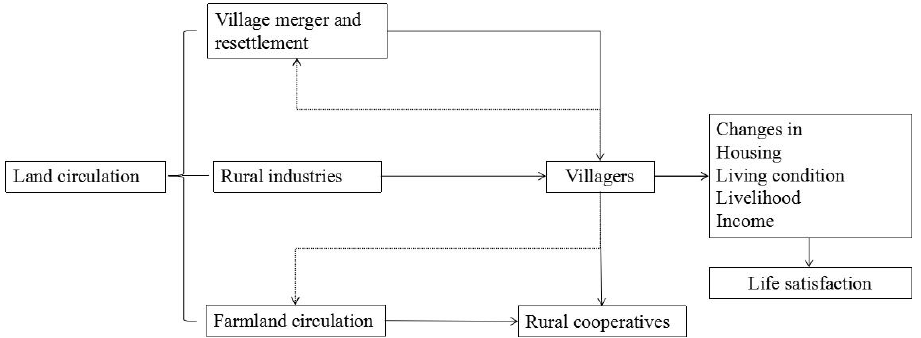
Figure 1. Conceptual model.